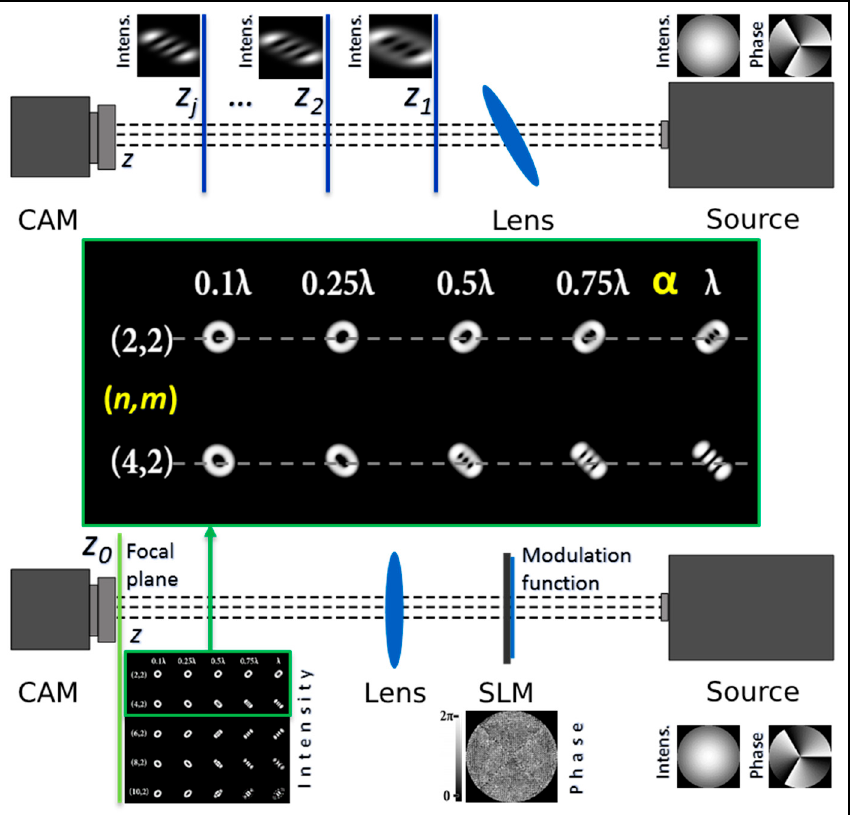
Figure 1. Principle of operation for determining the vortex TC ( l = 3) in a standard way (upper part) using a tilted lens and detecting the intensity distribution in several planes ( z 1 , z 2 , …, z j ) and the proposed approach (lower part) based on multi-channel DOE matched with astigmatic aberrations exp [ ik α Z n ,2 ( r , ϕ )] of different levels α in a single focal plane z 0